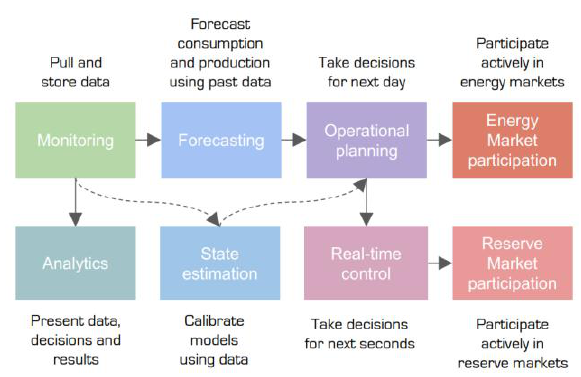
Fig. 2. Intelligent MG EMS design